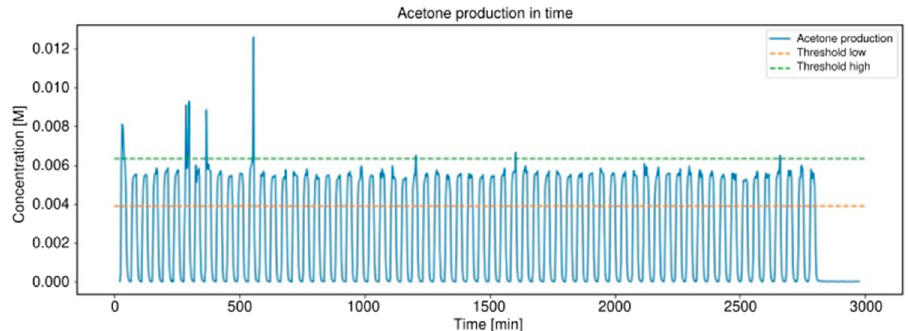
Figure 5. Acetone production (measured concentration minus 10 mM acetone baseline) measured over time using UV-visible spectroscopy with quantification through deconvolution with first-derivative spectra.